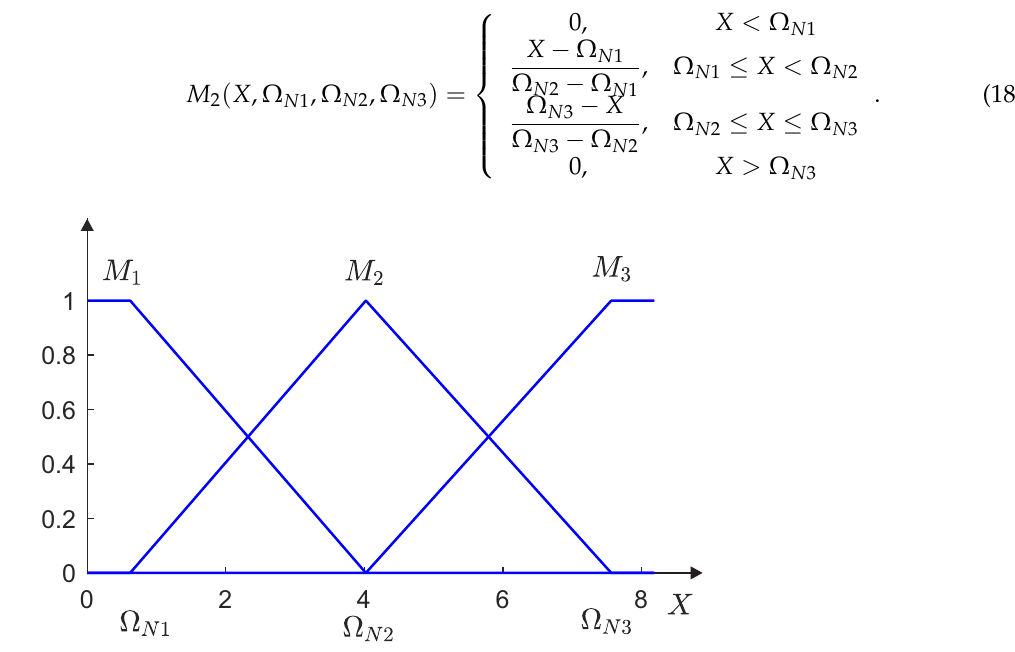
Figure 1. Membership